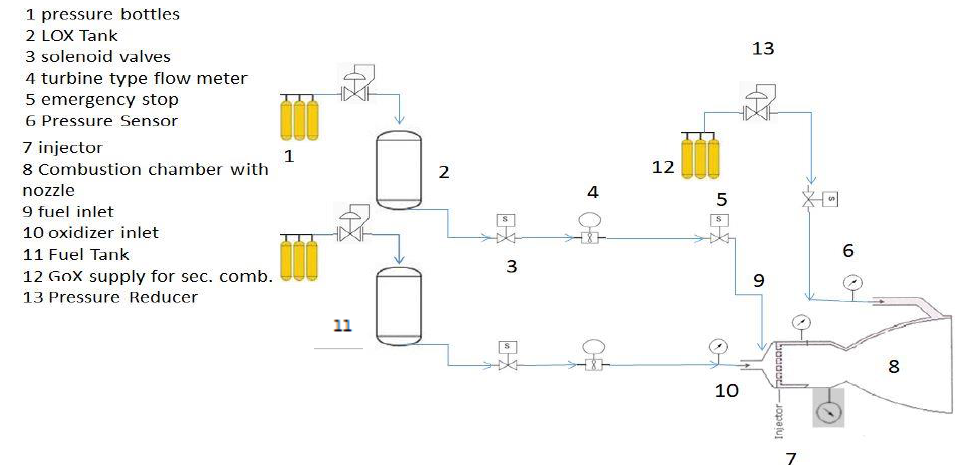
Figure 13. Process and instrumentation layout of the experimental setup. Table 9. Specifications of experimental apparatus.